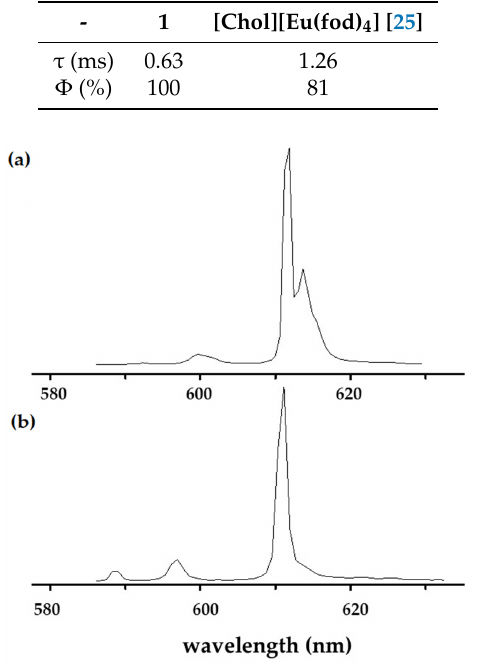
Figure 2. Normalized emission spectra of ( a ) 1 and ( b ) [Chol][Eu(fod) 4 ], relative to the most intense 5 D 0 → 7 F 2 transition band at 30 °C in the solid state. Higher lifetime of the 5 D 0 excited state (Table 1) is an indication of poorly efficient nonradiative relaxation processes due to the good shielding of the Eu (III), which is related, in this case, not only with the nature of the β -diketonate ligand, tetrakis-1,1,1,2,2,3,3-heptafluoro-7,7-dimethyloctane-4,6- dionate (fod), but also with the nature of the counter-ion. Assuming residual anion-cation interactions at room temperature, an absolute quantum yield of 100% for 1 could be explained by the absence of any cation interaction with the “fod” ligands which is responsible for the antenna effect that increases the luminescence efficiency of Eu(III) center. The emission profiles were measured at excitation wavelengths obtained from their corresponding excitation spectra, 345 nm for 1 and 340 nm for [Chol][Eu(fod) 4 ].